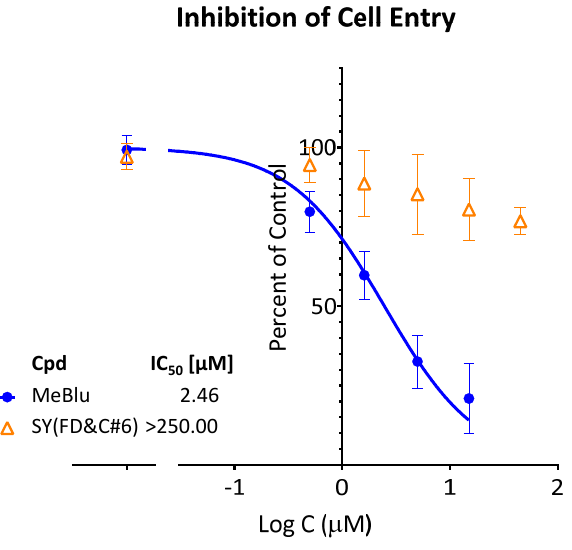
Figure 6. Concentration-dependent inhibition of the entry of SARS-CoV-2 pseudovirus (VSV- ∆ G) into hACE2/Furin-expressing cells by MeBlu. Entry of VSV- ∆ G pseudoviruses bearing the SARS-CoV-2